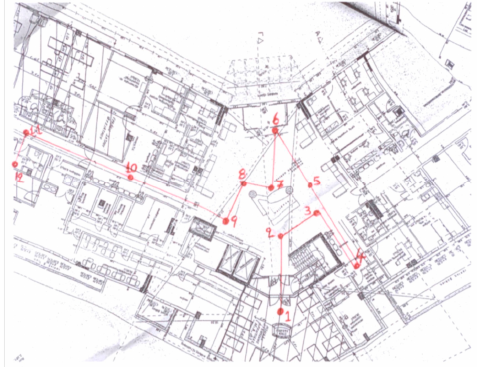
Figure 2. Navigation trail used to evaluate MOBOT cognitive assistance.